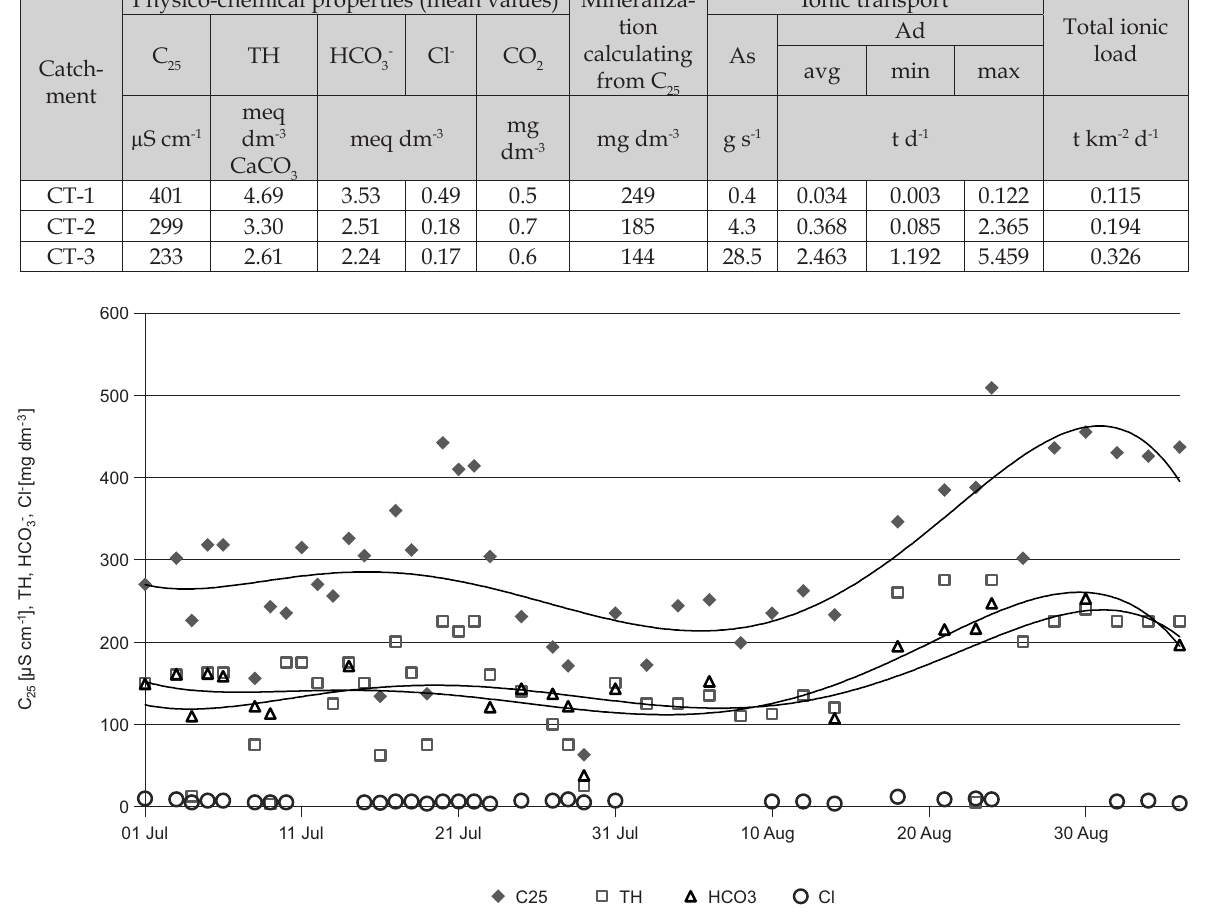
Fig. 6. Electrical conductivity (C25), concentration of Cl - and HCO